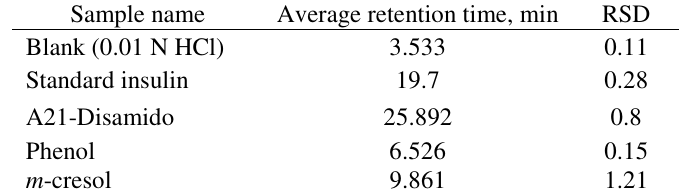
Table 1. Specificity of the insulin RP-HPLC assay